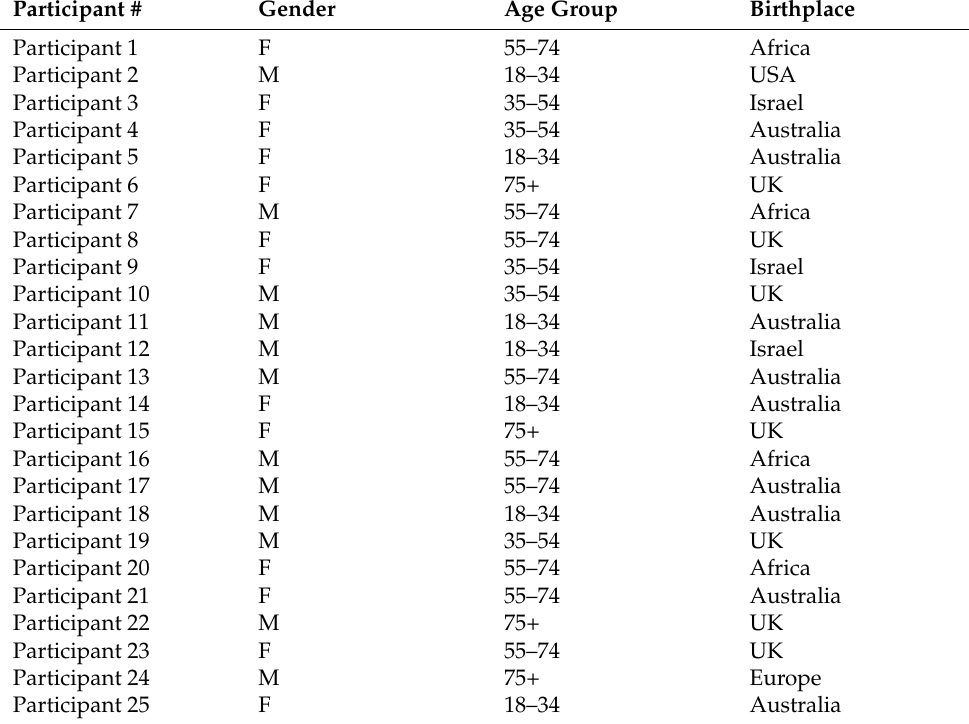
Table 1. Demographic characteristics of participants ( n =